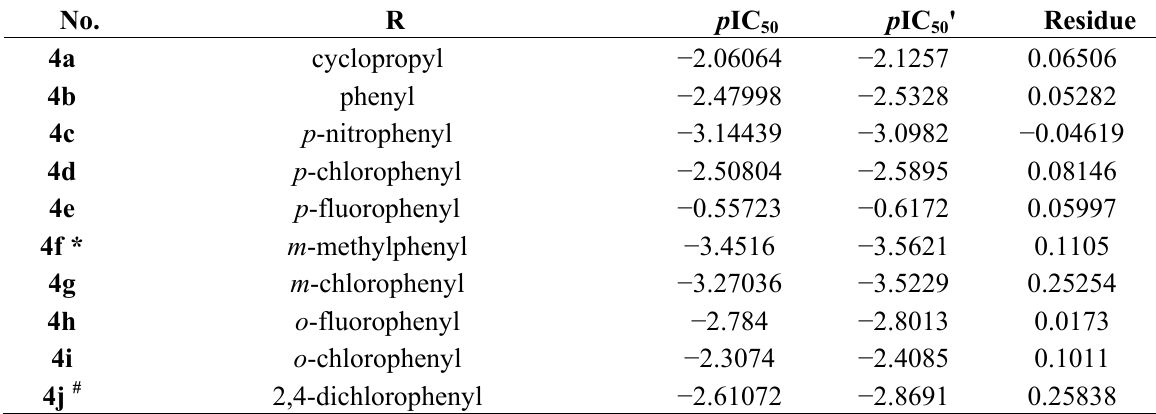
Table 5. The structures, activities and total score of